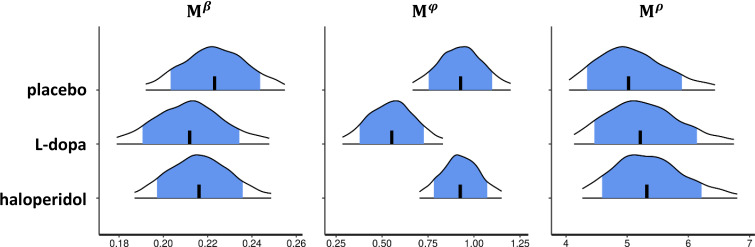
Drug effects for the group-level parameter estimates of the best-fitting Bayesian model.Shown are posterior distributions of the group-level mean (M) of all choice parameters (β, φ, ρ), separately for each drug condition. Each plot shows the median (vertical black line), the 80% central interval (blue (grey) area), and the 95% central interval (black contours); β: random exploration, φ: directed exploration; ρ: perseveration parameter. For drug effects on the standard deviation of the group-level median parameters φ,β and ρ see Appendix 1—figure 1a. See Appendix 1—figure 1b and c for pairwise drug-related differences of the group-level mean (M) and (c) standard deviation (Λ) of φ.